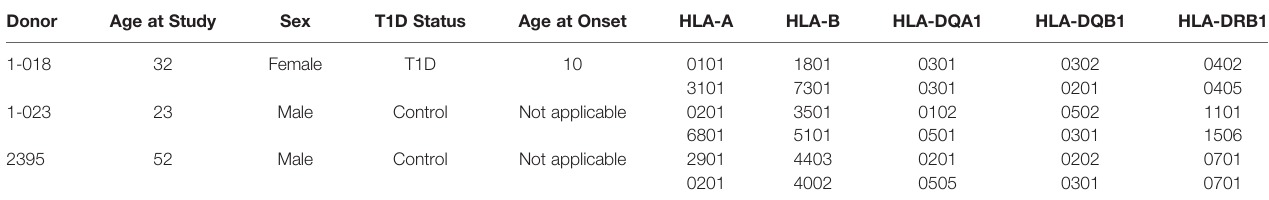
TABLE 1 | iPSC Donor Demographics and HLA Alleles for lines 1-018, 1-023, and